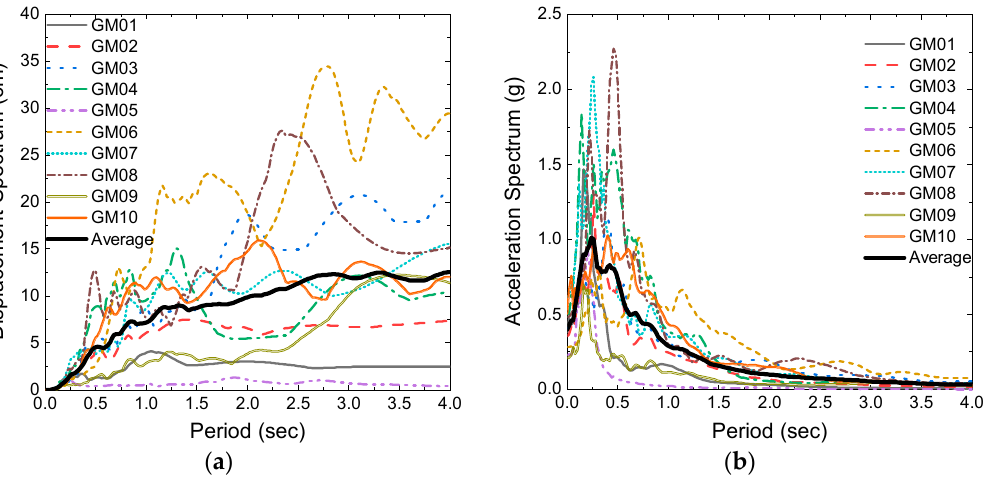
Figure 2. Response spectrum of the selected input ground motions. ( a ) Displacement response spectrum; ( b ) acceleration response spectrum.